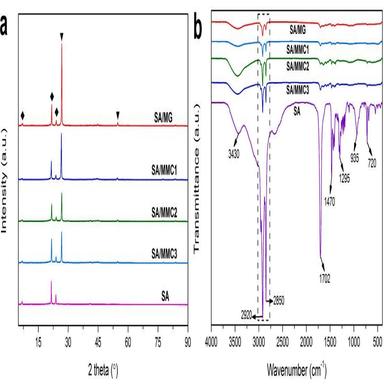
(a) XRD patterns and (b) FTIR spectra of pure SA, SA/MG, and SA/MMCs.